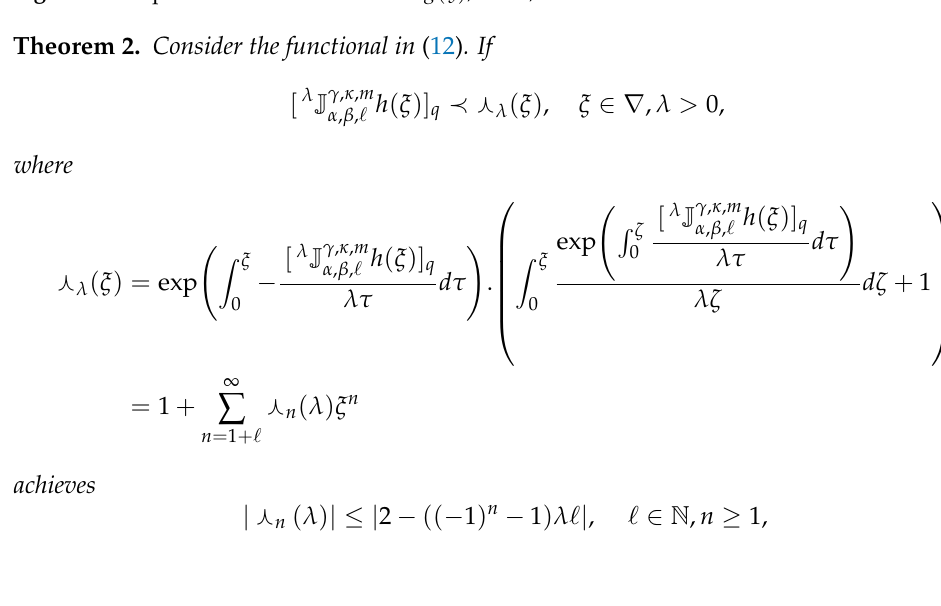
Figure 3. The plot of the convex function g ( ξ ) , (cid:96) = 1, λ =